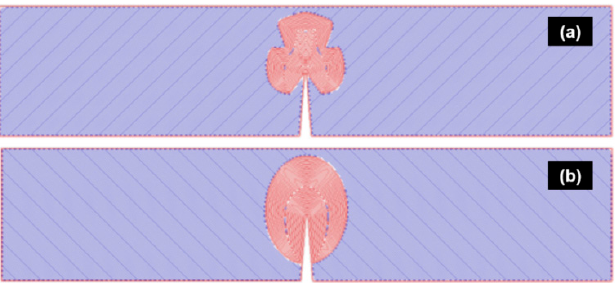
Figure 10. Deposition trajectories from the G code of the SENB specimen after applying the optimization method on the V notch vicinity. ( a ) First principal direction and ( b ) second principal direction.